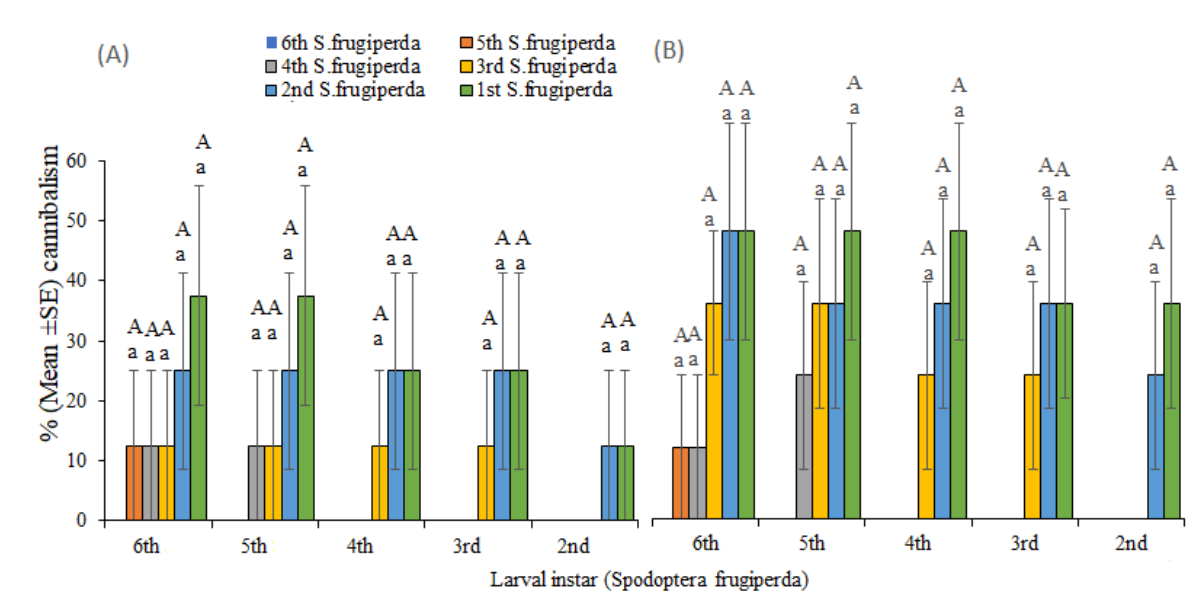
Figure 4. Cannibalism rate (mean ± SE) of different larval instars of Spodoptera frugiperda on given instars of the conspecifics on ( A ) maize plant and ( B ) Petri dish after 24 h feeding. Different lowercase letters above error bars reflect significant differences in cannibalism rate of each larval development stage of Spodoptera frugiperda on their conspecifics, and different uppercase letters indicate significant differences of larval stages of Spodoptera frugiperda across different instars of their